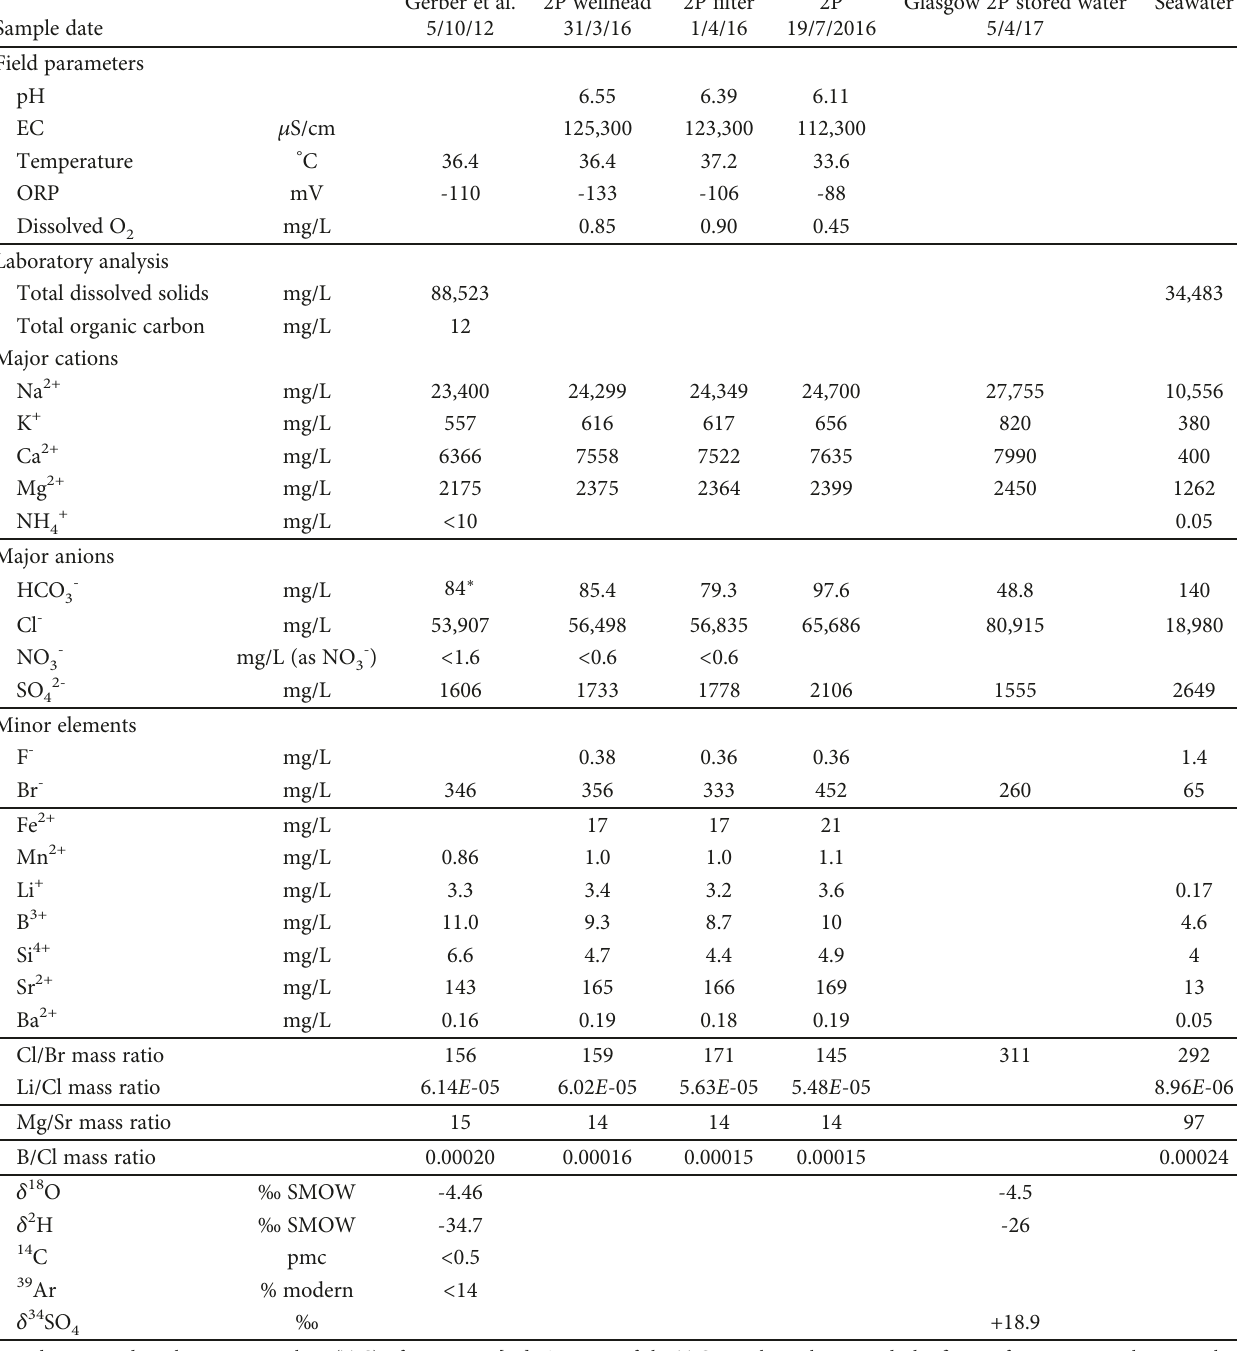
Table 3: Chemical composition of groundwater from Klaipeda Geothermal Demonstration Plant, showing analysis on a sample collected 5/10/2012 [17], three samples collected and analysed by GFZ-Potsdam in March-July 2016 from well 2P, and a sample collected on 5/4/17, from bulk water storage, and analysed by Glasgow University/SUERC. The fi nal column shows standard sea water as reported by [18, 19]. An analysis of water from 2P in 2010 [9] reported concentrations of 3.2 μ g/L As and 0.06 μ g/L U. Additional analyses are available in GTN reports